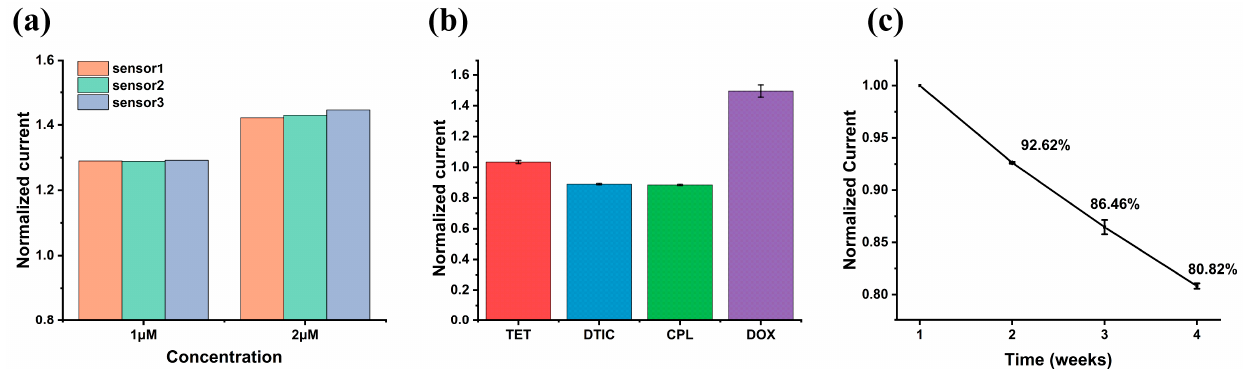
Figure 5. ( a ) Normalized SWV currents of 3 different aptasensors responding to 1 µ M and 2 µ M DOX were used to evaluate the repeatability of the sensors; ( b ) normalized SWV current responses of aptasensors to 50 µ M of TET, DTIC, CPL, and 4 µ M DOX, respectively; ( c ) stability of the proposed sensor for three weeks.